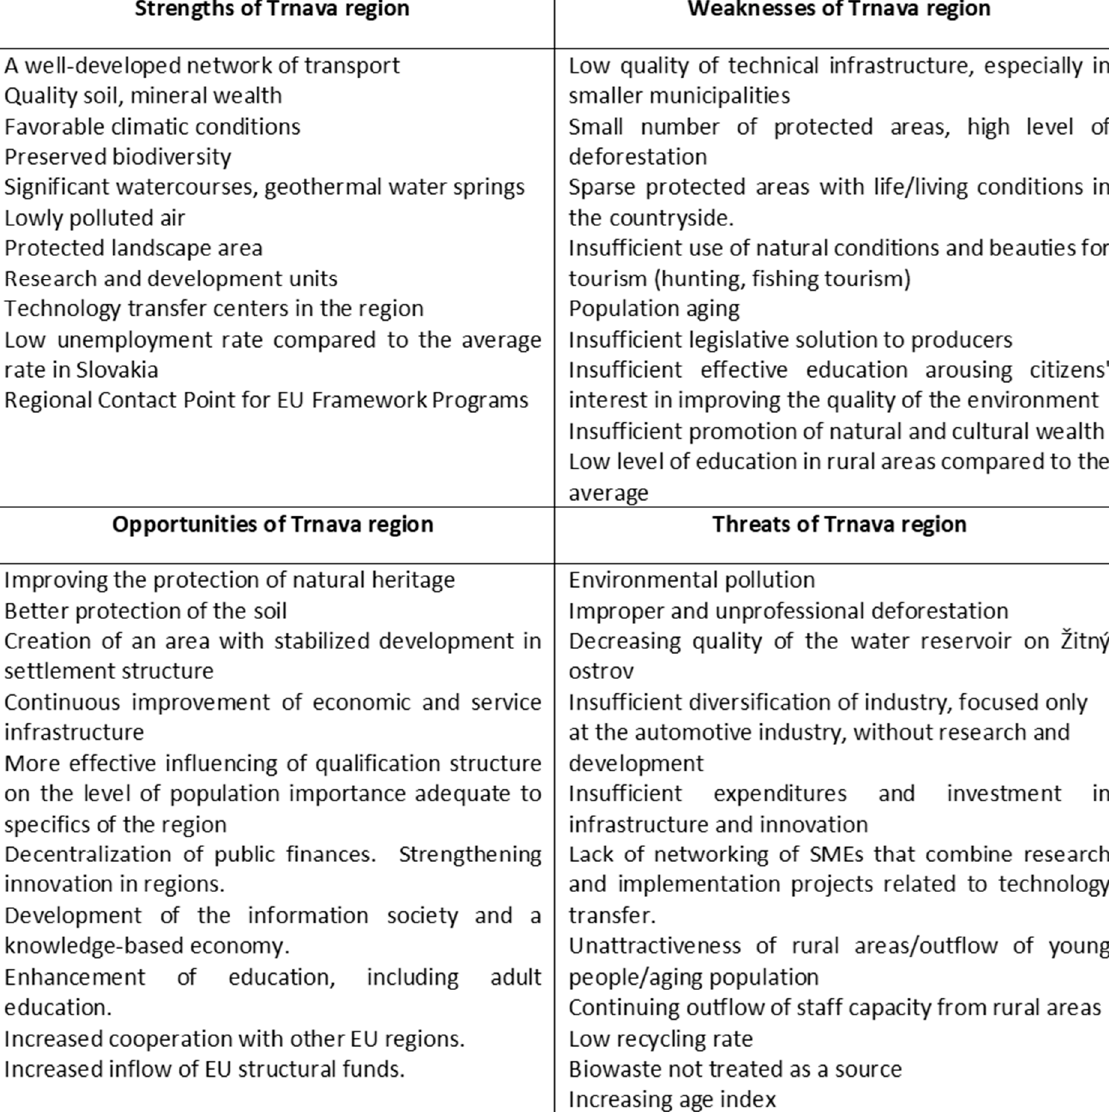
Figure 3. SWOT analysis: characteristics of the Trnava region (Trnava self-governing region). Source: drawn by authors based on data from [40–42].